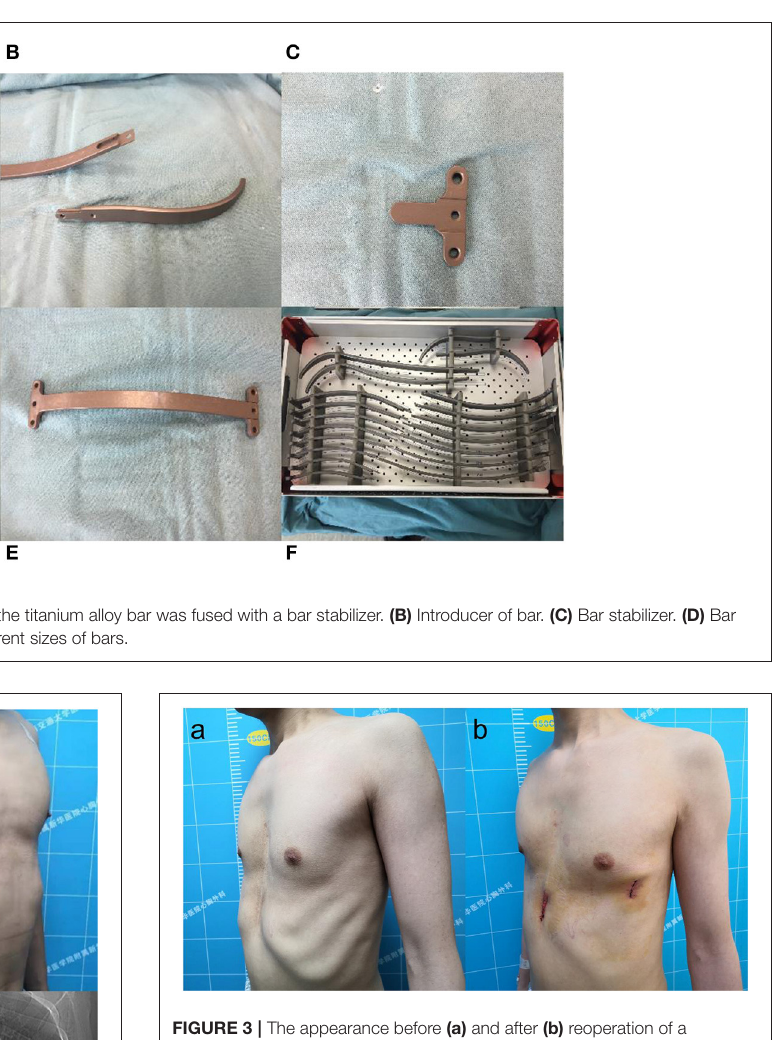
FIGURE 3 | The appearance before (a) and after (b) reoperation of a 33-year-old patient with recurrent pectus excavatum after Ravitch procedure.